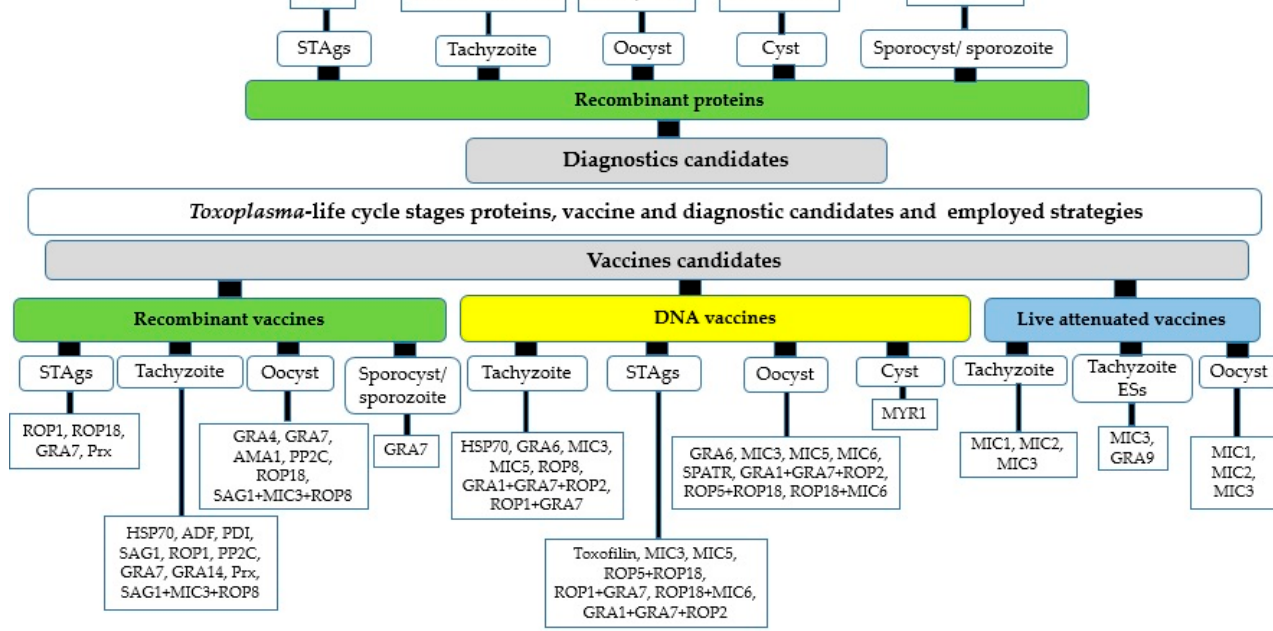
Figure 2. Toxoplasma vaccine and diagnostics candidates inferred from proteomics data.